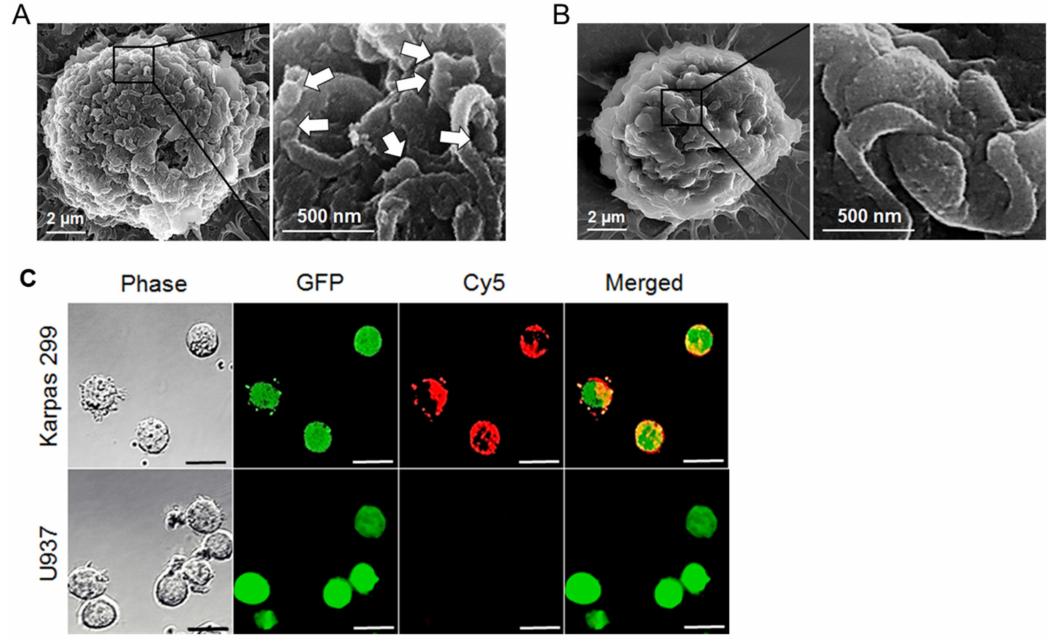
Figure 5. Functional study of protamine nanomedicine. ( A ) Cell-targeting study by scanning electron